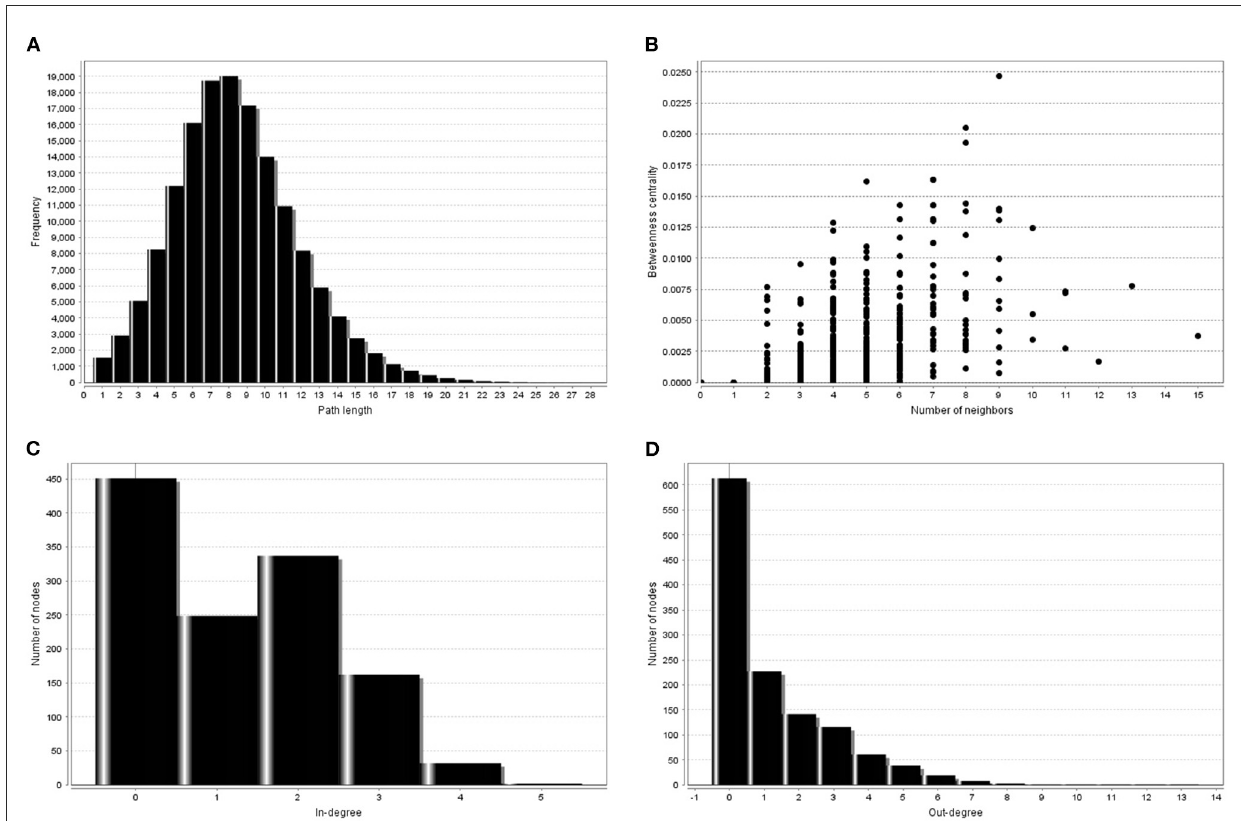
FIGURE2 Some topological measures of trained gene regulatory BN visualized by NetworkAnalyzer . (A) Shortest path length distribution. The path length is the number of edges along the path. The distance d ij between a pair of different nodes i and j is the length of the shortest path connection. (B) Between-ness centrality. The Between-ness centrality of a node reflects the amount of control that this node exerts over the interaction of other nodes in the network. (C) Distribution of in-degree gene connectivity measure. (D) Distribution of out-degree gene connectivity